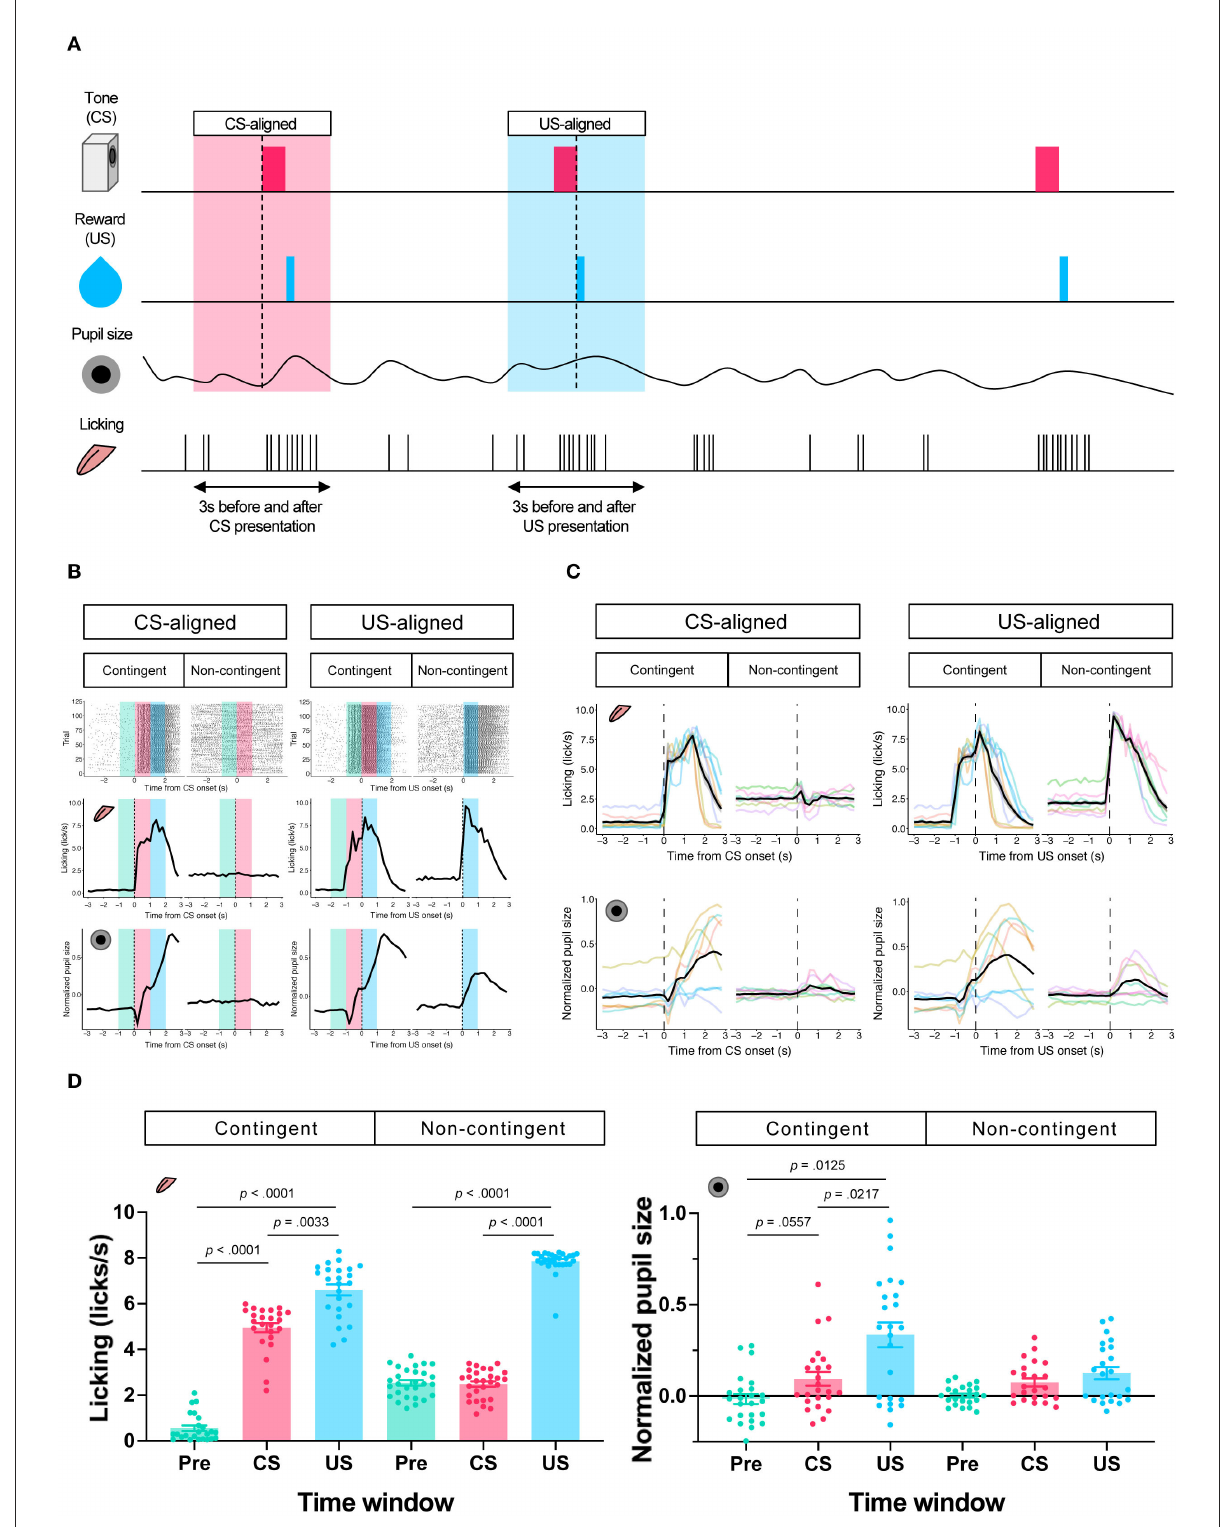
FIGURE2 Results of the Pavlovian conditioning training. (A) Schematic representation of analyzed time windows. The presentation of CS or US was set as 0, and the 3s before and after the presentation were used for analysis. (B) An example of licking responses and pupil response during